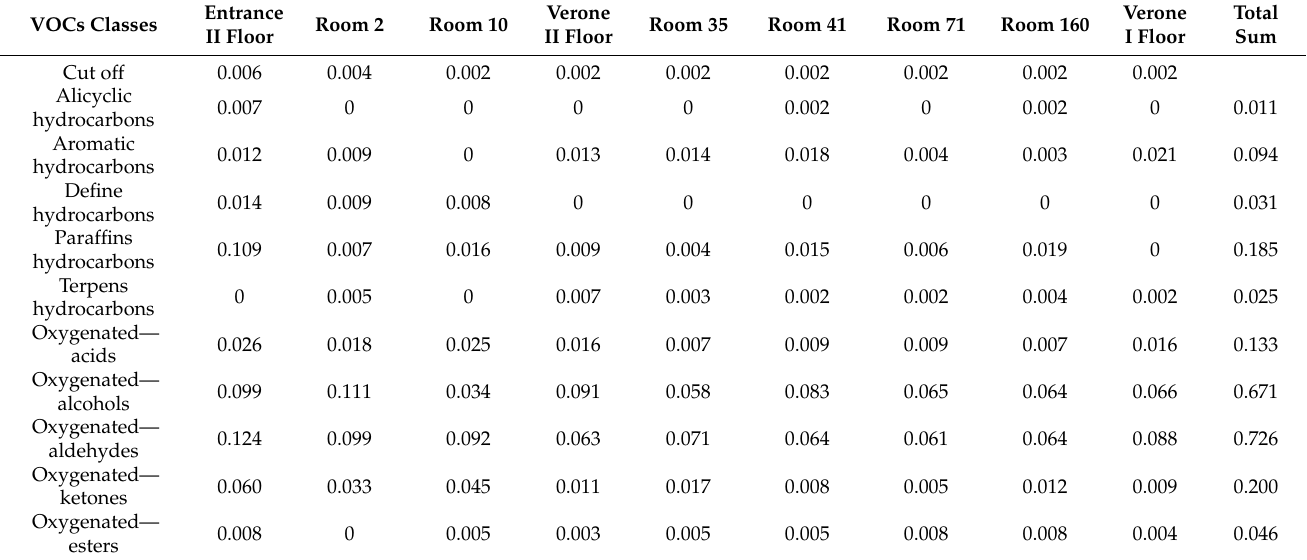
Table 8. VOCs classes and relative concentrations (mg/m 3 ) in the analyzed rooms of the Uffizi Gallery.